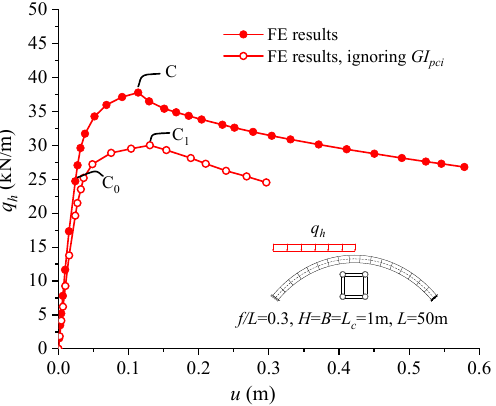
Figure 18. Out-of-plane vault displacements for the typical Vierendeel truss arch under HSUVLs.